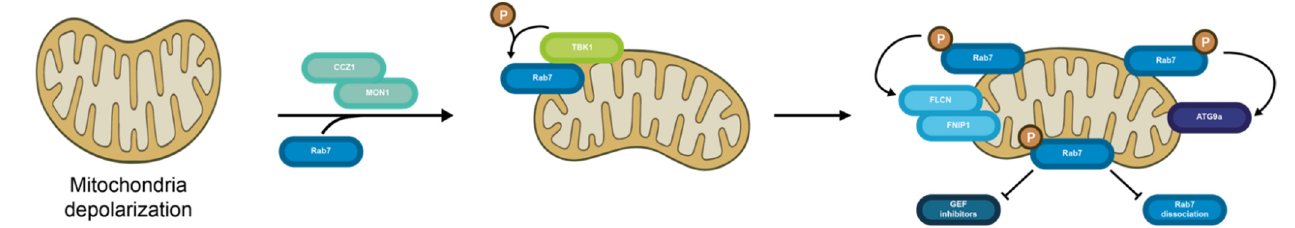
Figure 4. Effects mediated by Rab7 upon mitochondria depolarization. Rab7 phosphorylation on serine 72 by the mitochondrial outer membrane kinase TBK1 triggers recruitment of FLCN-FNIP and ATG9a. Moreover, loss of interactors with GDP dissociation inhibitors, and an increase in Rab7 presence in mitochondria membrane, favors